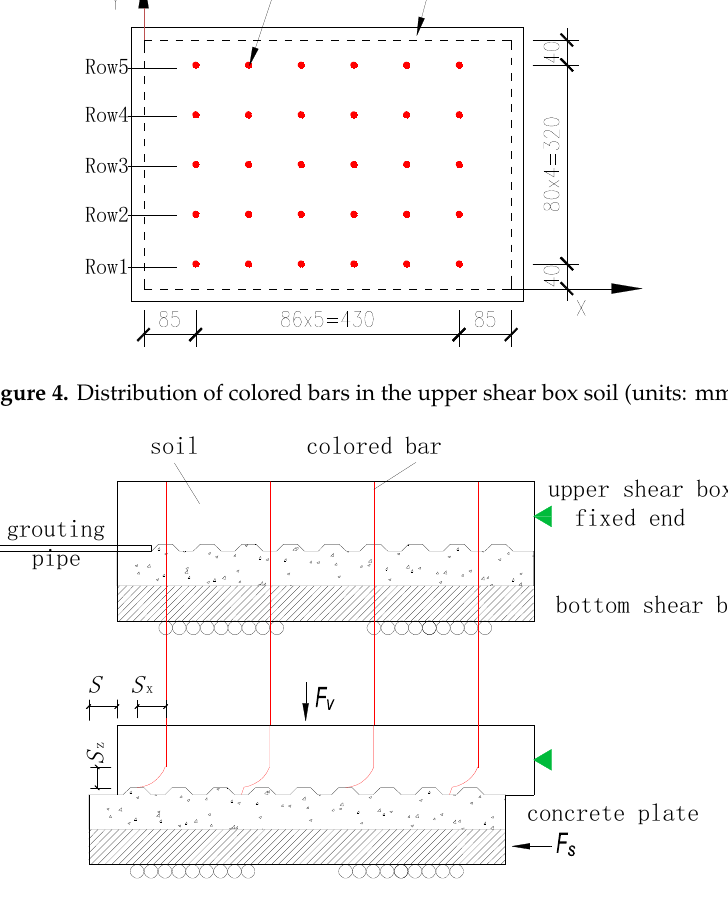
Figure 5. Schematic diagram of the shearing process and formation of the shear band.